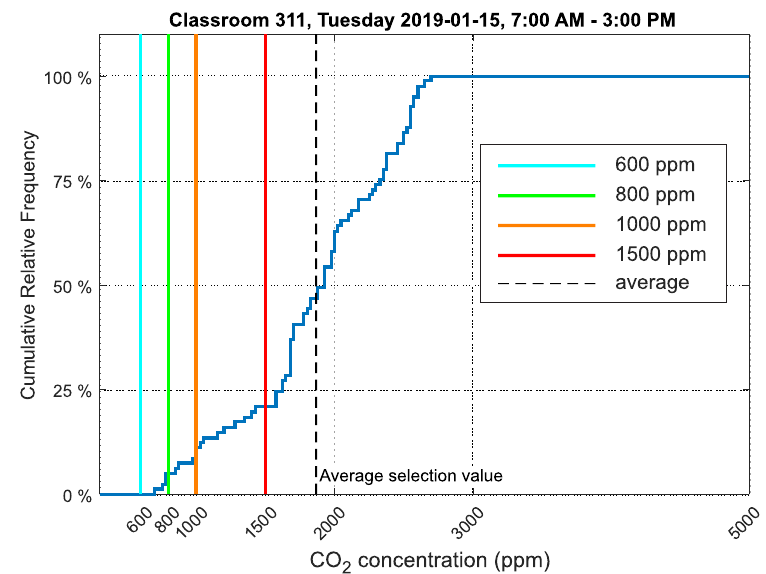
Figure 16. Cumulative relative frequency graph of the data selection showing CO 2 concentration in classroom number 311, Frenštát pod